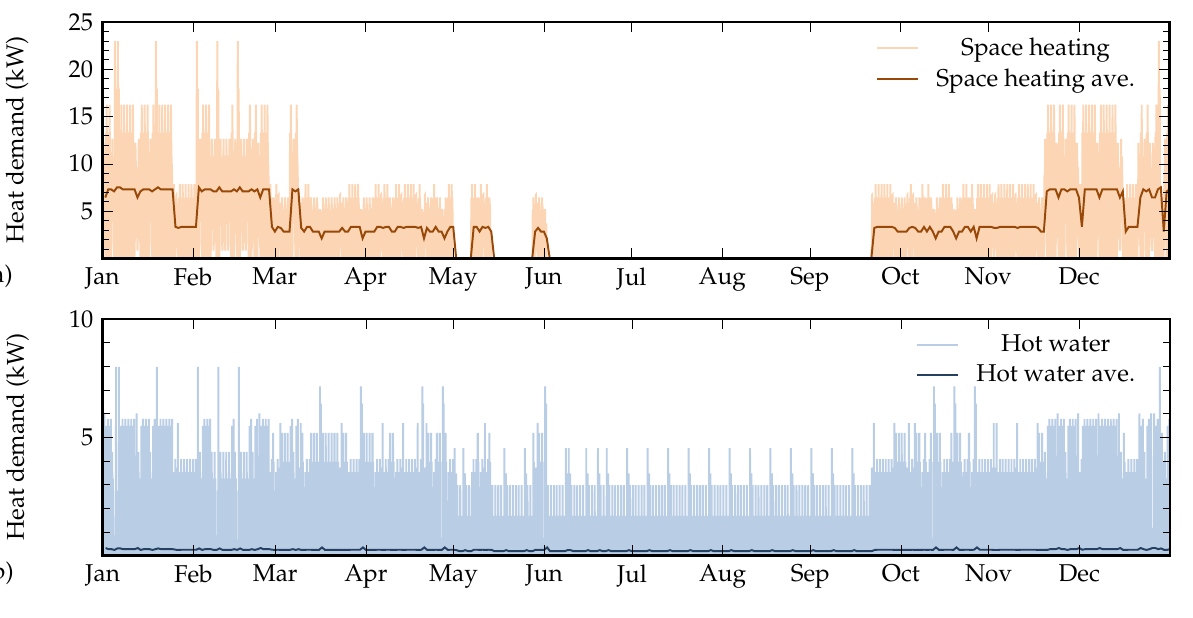
Figure 5. Heat demand of the modeled building for (a) space heating and (b) hot water over a year. The lighter colored values have a time resolution of 15 minutes per value, the darker colored values are daily averages.